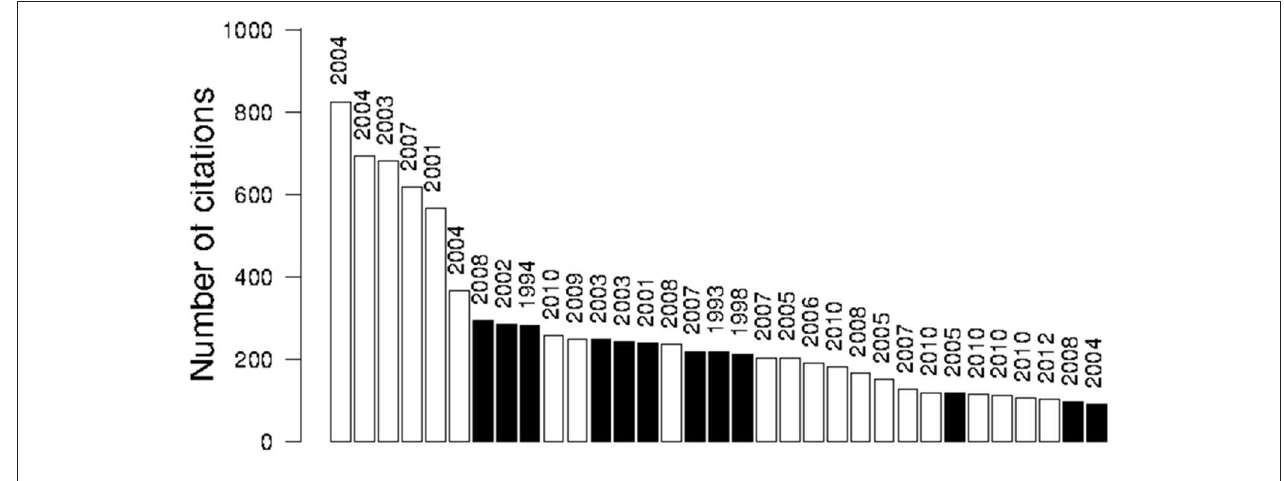
FIGURE 1 | The 35 most cited data-free (white) and empirical papers (black) discussing individual behavioral variation or animal personality as of December 12th 2014 on Web of Science. Year of publication of each